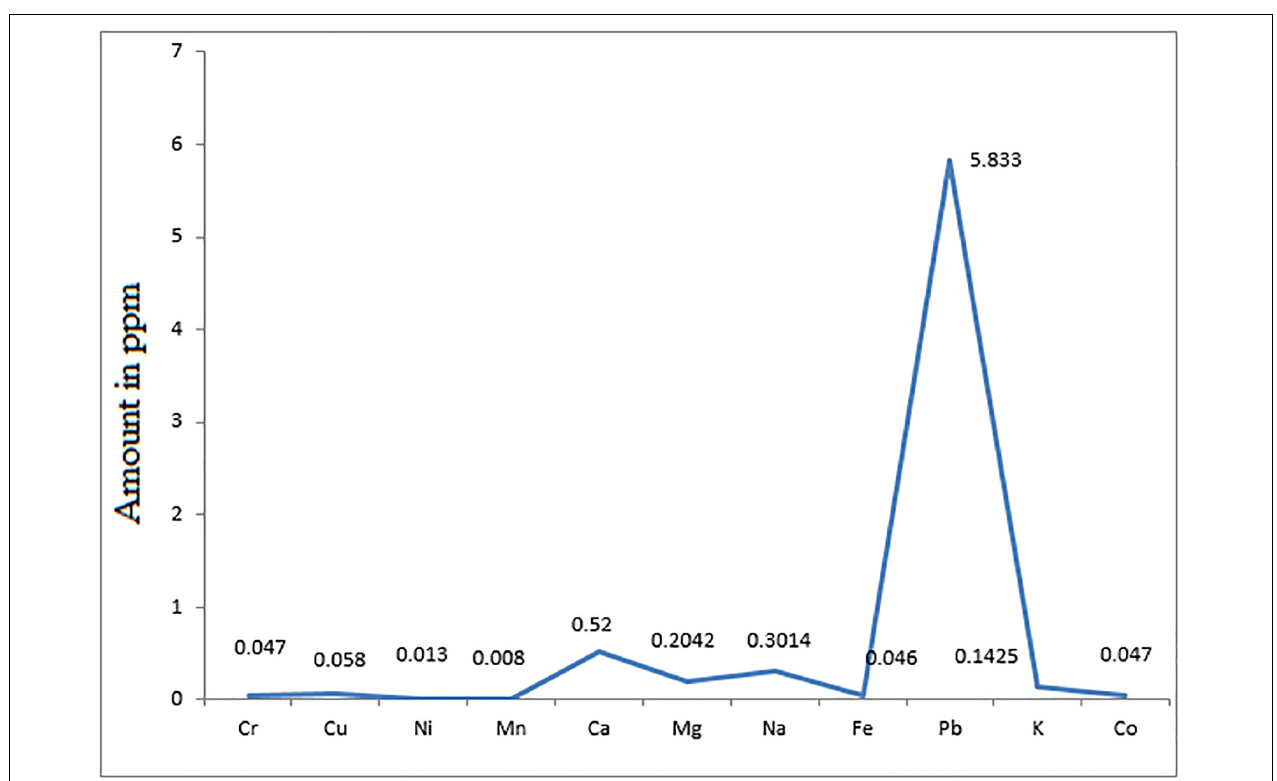
FIGURE 11 | Concentration and Distribution of Various Elements in Energy Crop Cocklebur Methyl